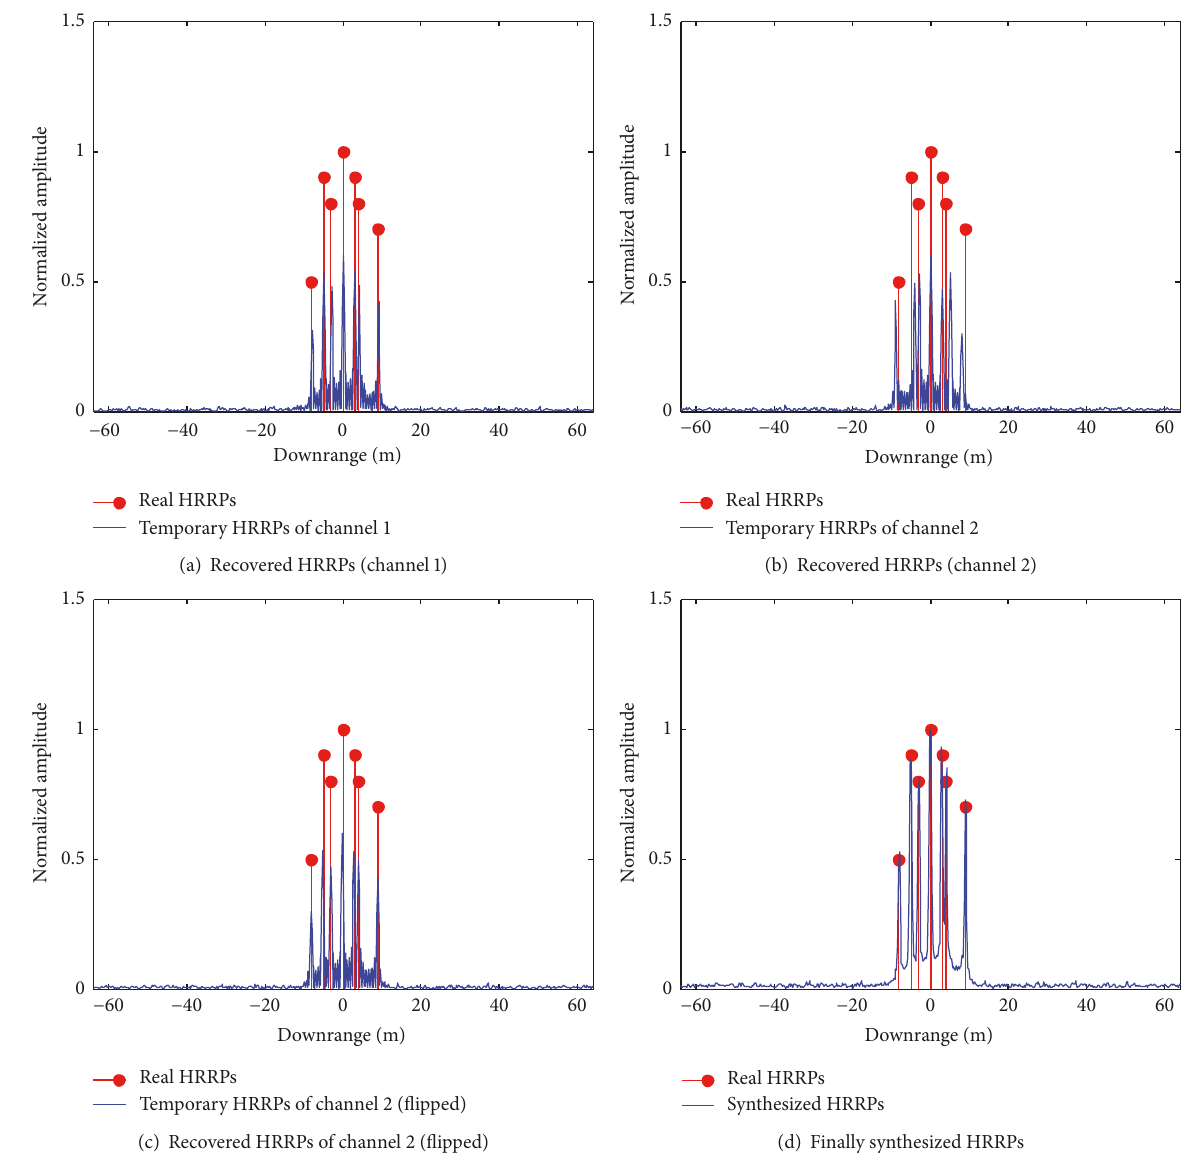
Figure 5: HRRPs reconstruction (SNR = 20